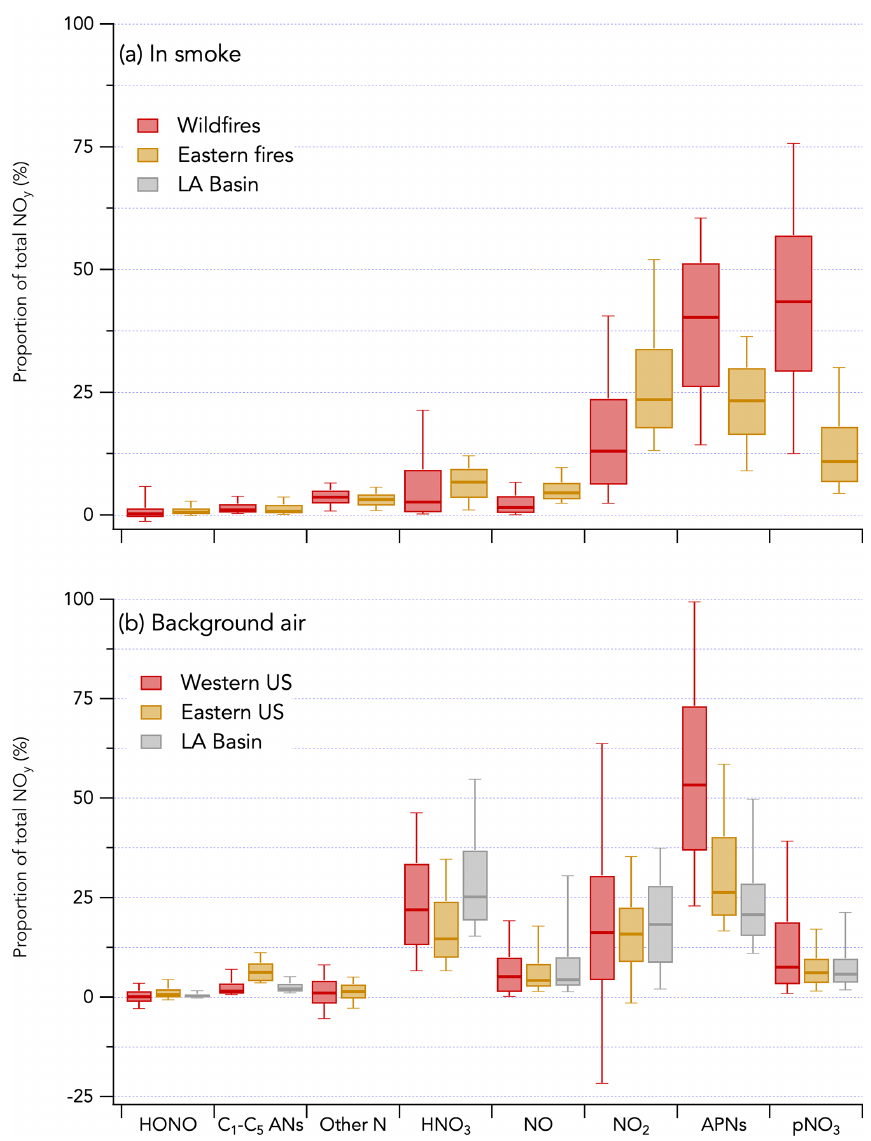
Figure 10. Contribution of individually measured reactive odd nitrogen species to the total NO y budget during FIREX-AQ. The campaign is separated in three periods (wildfires sampling period in red, eastern fires sampling period in yellow, and Los Angeles (LA) Basin flights in grey). Panel (a) shows the NO y budget in smoke plumes, while panel (b) shows that in background air. C 1 –C 5 alkyl nitrates are referred to as C 1 –C 5 ANs. Other nitrogen species include N 2 O 5 , CH 3 NO 2 , and alkene hydroxy nitrates. The box and whisker plots show the 10th, 25th, 50th, 75th, and 90th